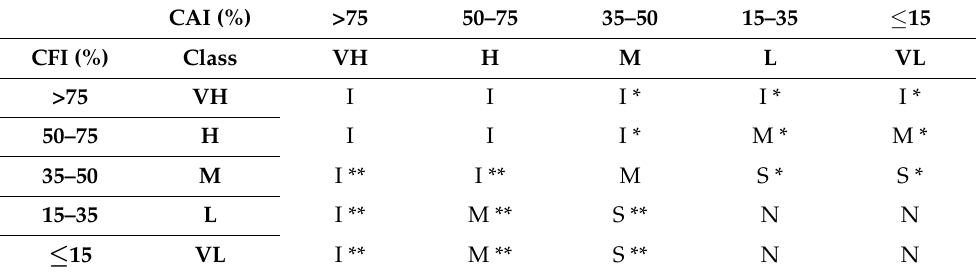
Table 2. Active-channel planform migration matrix (I: intense; M: moderate; S: slight; N: no/very slight) obtained from the combination of CAI and CFI classes (VH: very high; H: high; M: moderate; L. low; VL: very low). Each class includes its upper limit.